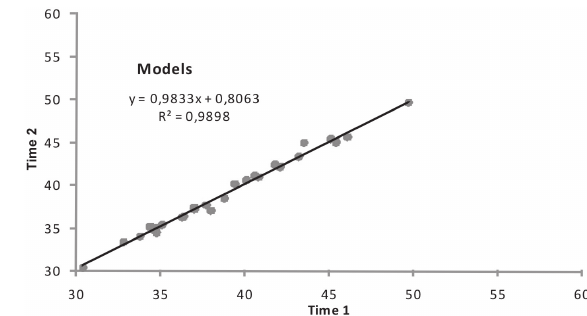
Figure 4- Control chart for the mean of differences between models